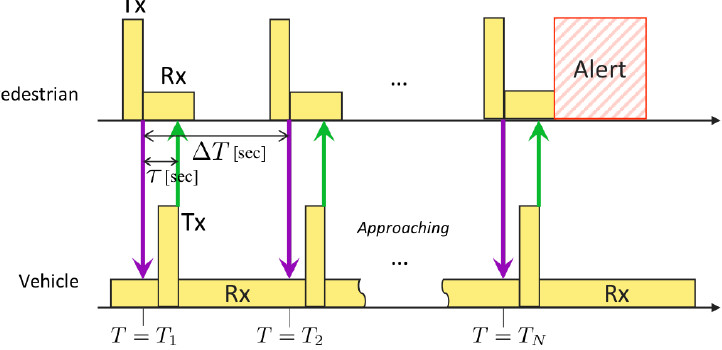
Figure 4. A sequence diagram of the ND-based